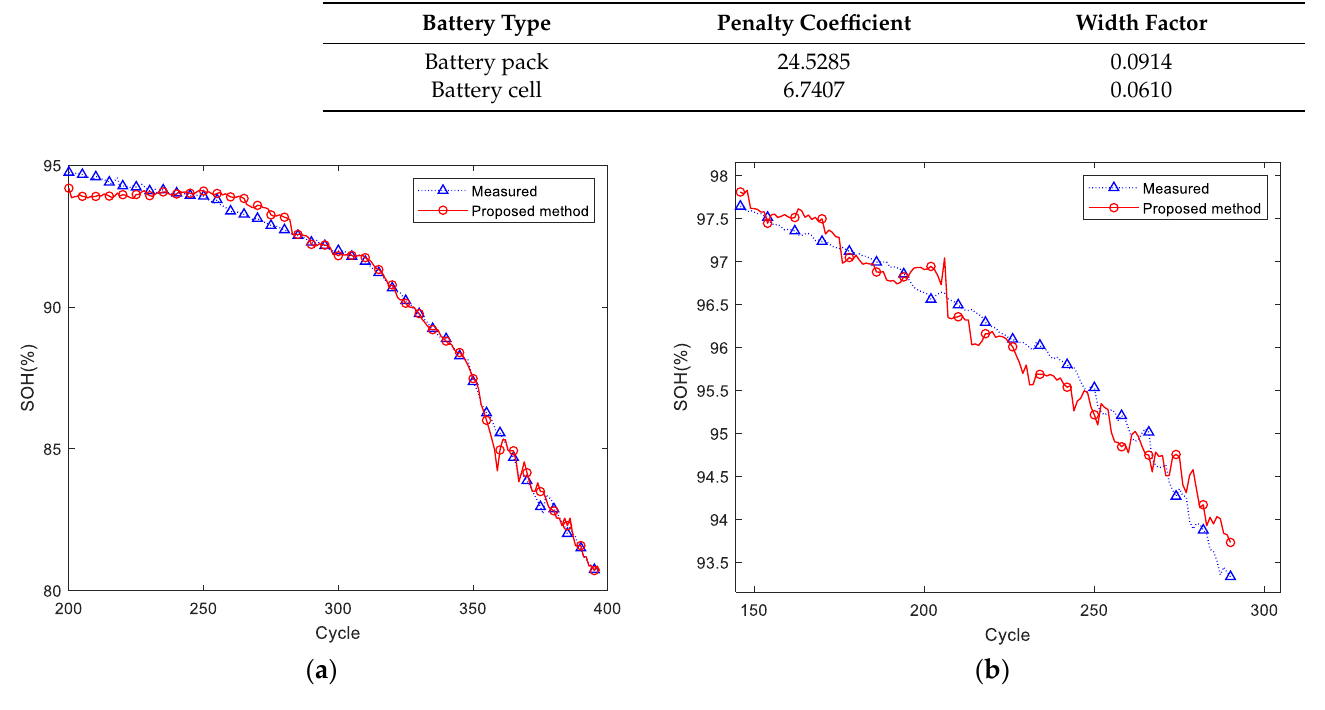
Figure 7. The estimation results of SSA-SVM. ( a ) Battery pack; ( b ) battery cell.